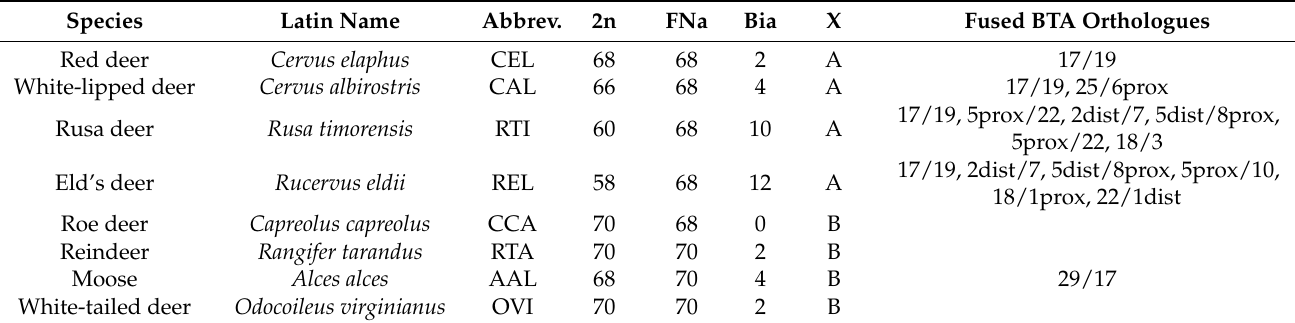
Table 1. List of analysed